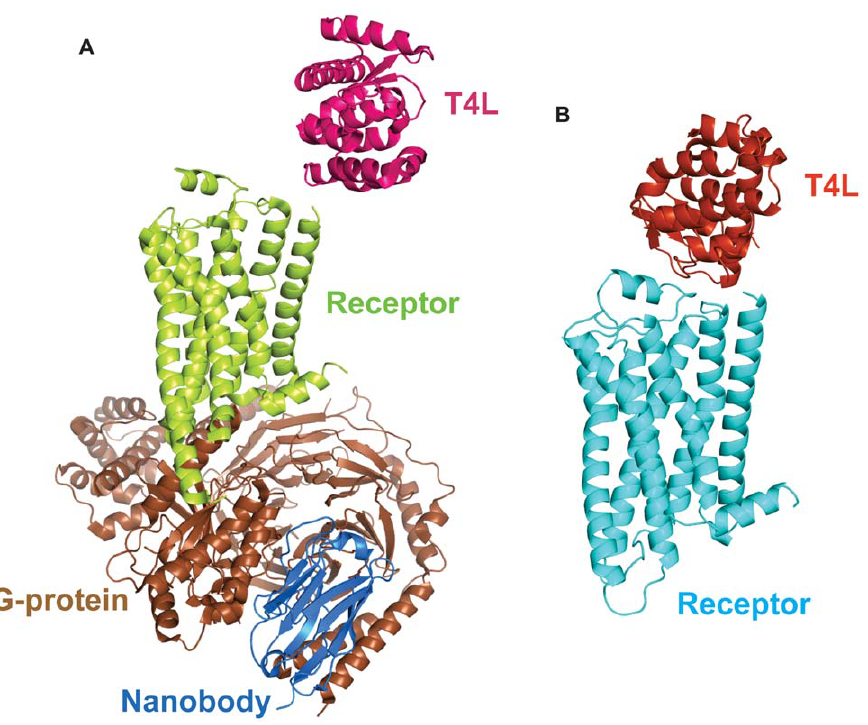
Figure 2. The T4L moiety in different crystal structures. A. The crystal structure of the b 2 AR-Gs complex. The T4L is shown in magenta. The b 2 AR is shown in green. The G-protein heterotrimer is shown in brown. The stabilizing nanobody is shown in blue. There are no interactions between the T4L and its fused b 2 AR. B. The crystal structure of T4L- b 2 AR- D ICL3. The T4L is shown in red and its fused b 2 AR- D ICL3 is shown in cyan. In contrast to the b 2 AR-Gs complex structure, there are interactions between the T4L and its fused receptor b 2 AR- D ICL3.